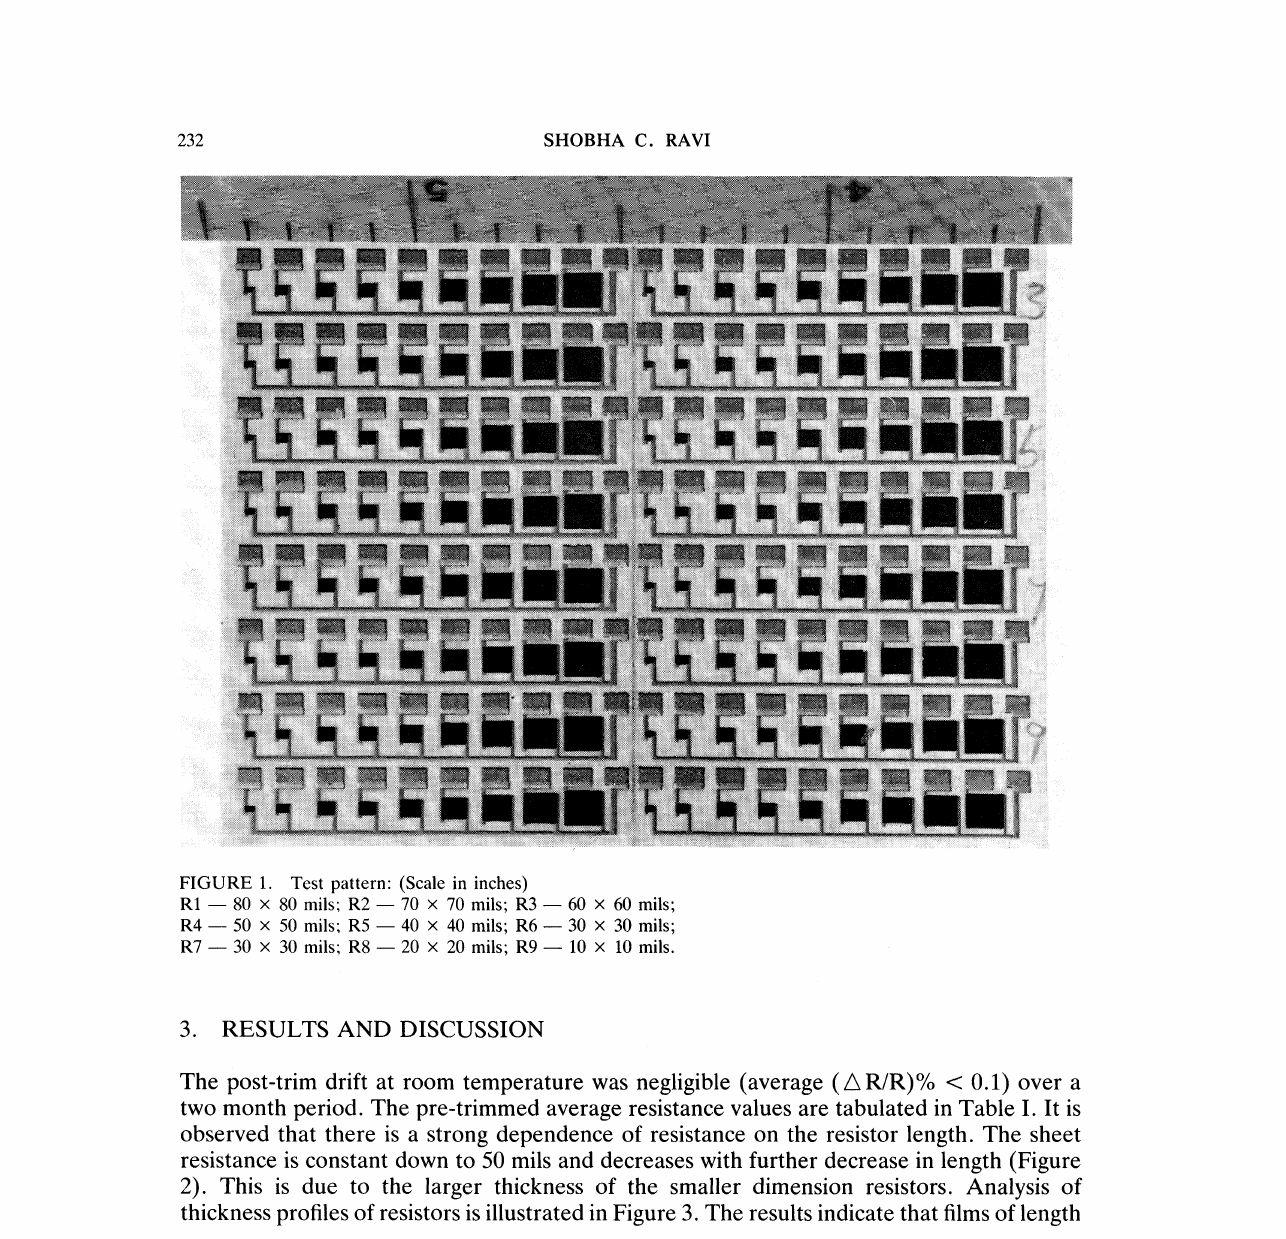
TABLE Pre-trimmed Average Resistance vs. Resistor